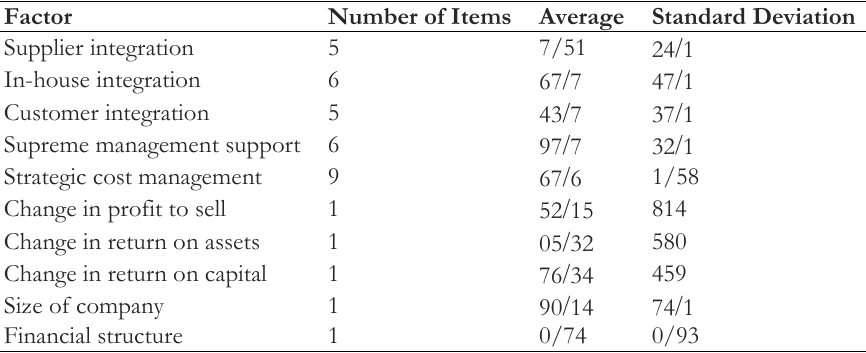
Table 1. Descriptive statistics of research